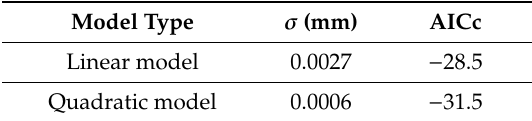
Table 1. Comparison of standard deviation of prediction error and AICc value of two crack width prediction models.